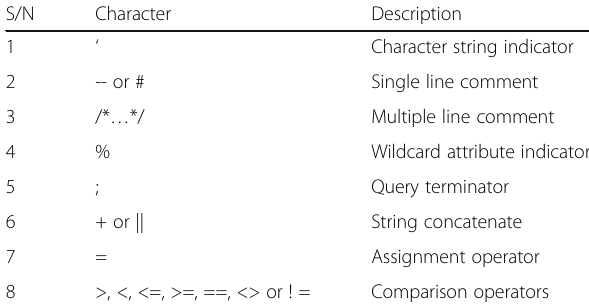
Table 1 Special characters used to compose SQL-injection code